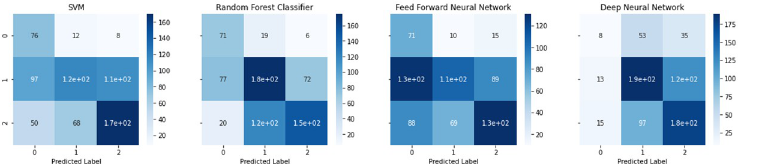
Fig 5. Confusion matrices obtained from predicted labels by performing Leave-one-out cross validation on the deep learning and machine learning models. Each confusion matrix reveals the performance of different ML algorithms on the same test set. It reflects the accuracy of an algorithm in predicting each class. The samples that fall in the main diagonal are correct predictions while off-diagonal instances are incorrect predictions. The proposed deep neural network can distinguish TBI and sham classes at an acceptable accuracy while naive class is difficult to